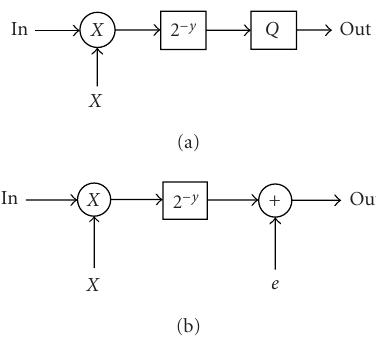
Figure 5: Signal flow graph of (a) coe ffi cient multiplier and (b) co- e ffi cient multiplier modeling quantization with the noise source e.